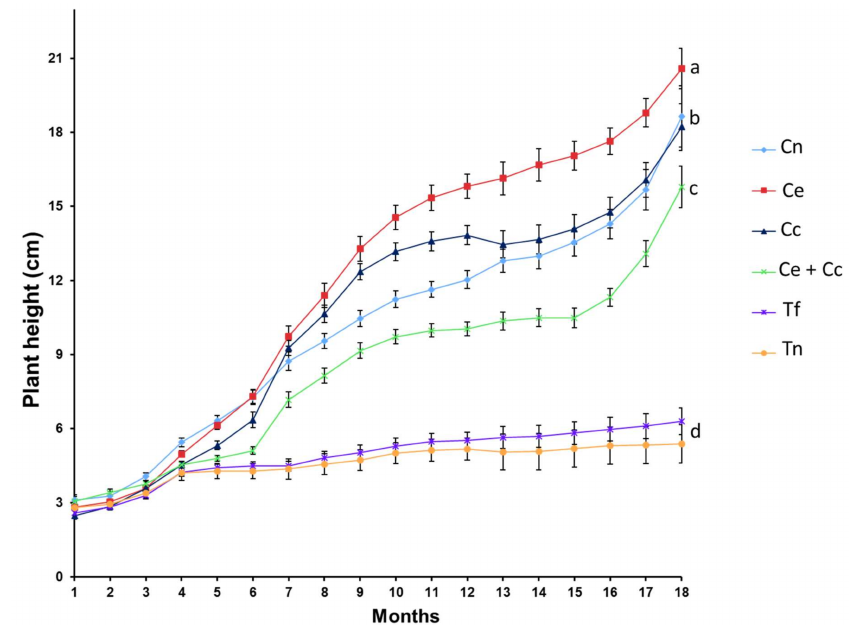
Figure 3. Heights of Agave maximiliana plants over 18 months after being inoculated with arbuscular mycorrhizal fungi (AMF). Treatments: (1) consortium of autochthonous AMF of the A. maximiliana rhizosphere (Cn), (2) Claroideoglomus etunicatum (Ce), (3) Claroideoglomus claroideum (Cc), (4) C. etunica- tum + C. claroideum (Ce + Cc), (5) control with fertilization and without mycorrhizal inoculation (Tf), and (6) control without fertilization or mycorrhizal inoculation (Tn). Ages 1–6 months, n = 18; ages 7–12 months, n = 13; ages 13–18 months, n = 8. Data are means ± standard error. Different letters (at 18 months) indicate significant differences between